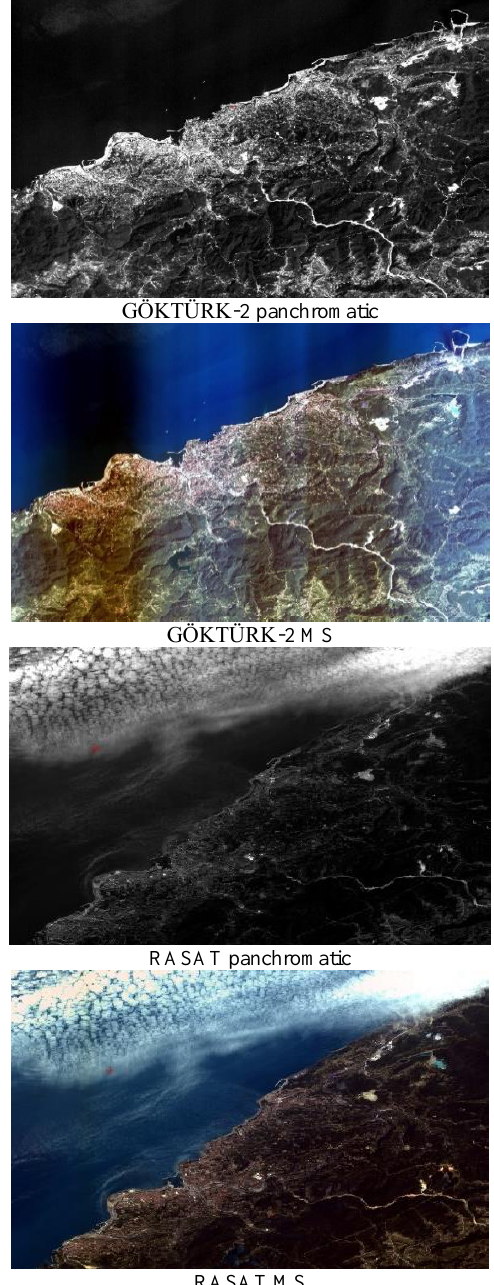
Figure 2. GÖKTÜRK-2 and RASAT images in Level